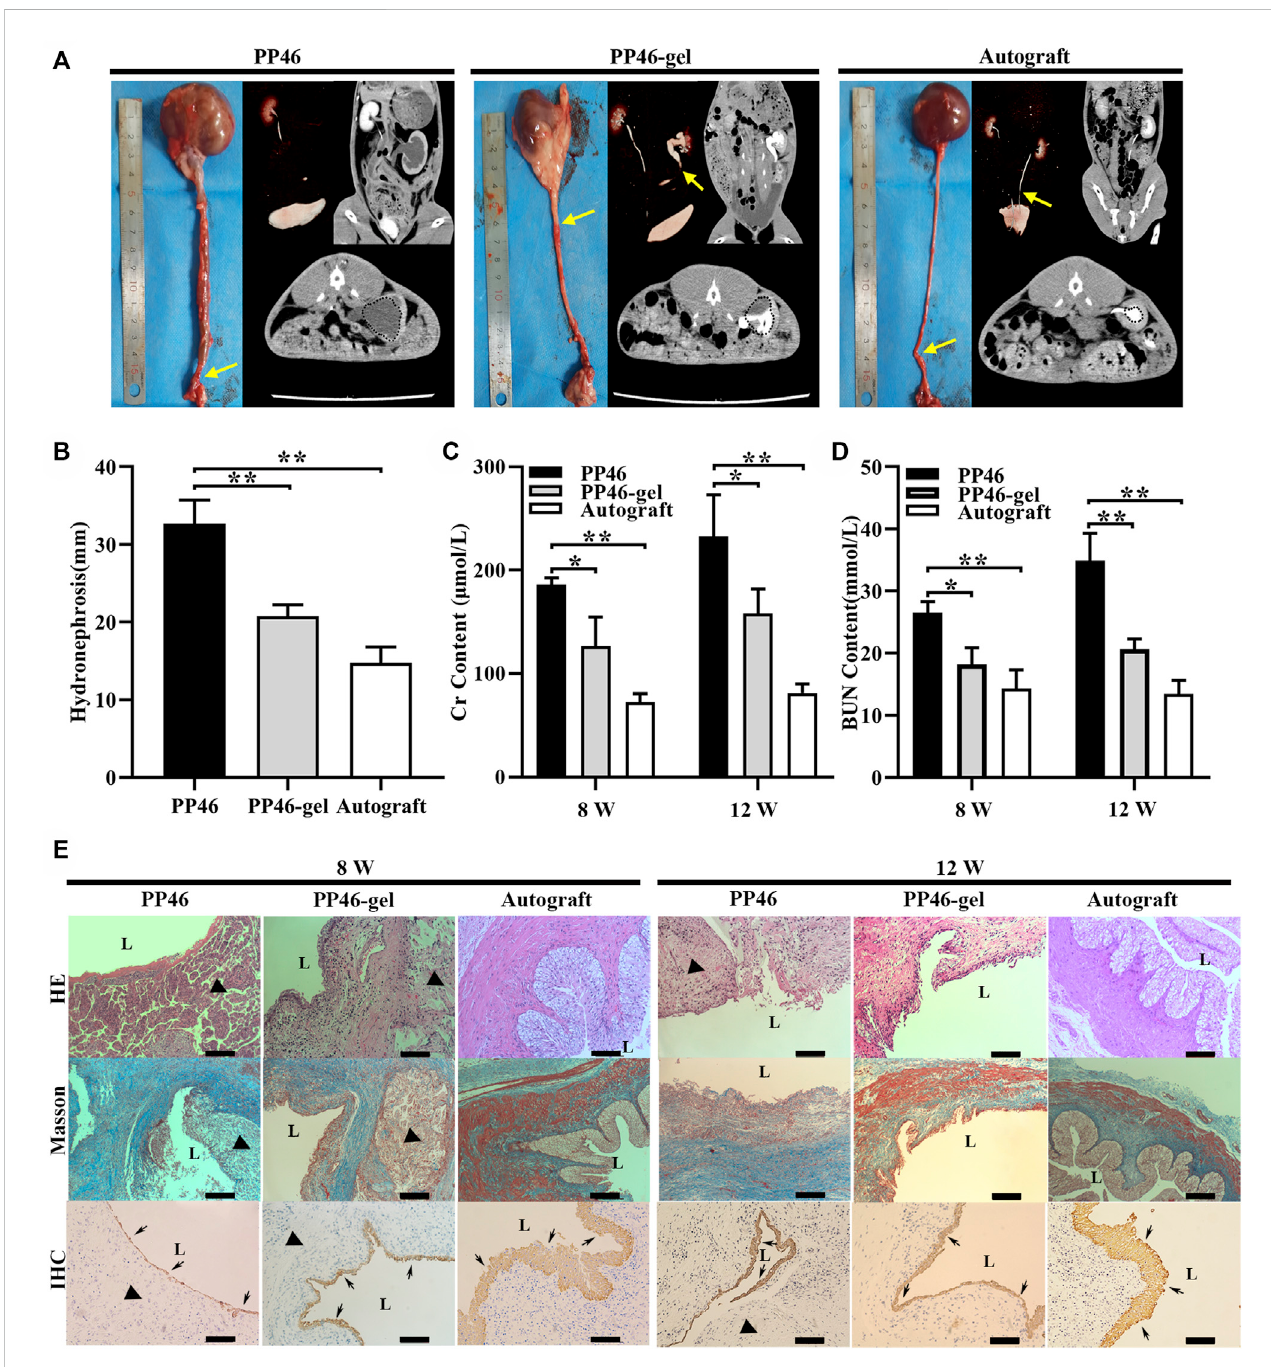
FIGURE 5 Results of the in vivo tests. (A) Gross and tomography of PP46 and PP46-gel with the autograft as the positive control. Yellow arrows denote ureteral obstruction. Dotted circles are hydronephrosis images in CT. (B) Degree of hydronephrosis evaluated from CT cross-sectional scanning postoperatively at 12 weeks. (C, D) Assessments of the Cr and BUN content after material implantation. (E) Histological analysis. L, lumen. The triangles indicate the location where scaffolds were implanted. Black arrows indicate AE1/AE3+ cells. Scale bar, 100 μ m. Data are presented as mean ± SD (* p < 0.05; ** p <